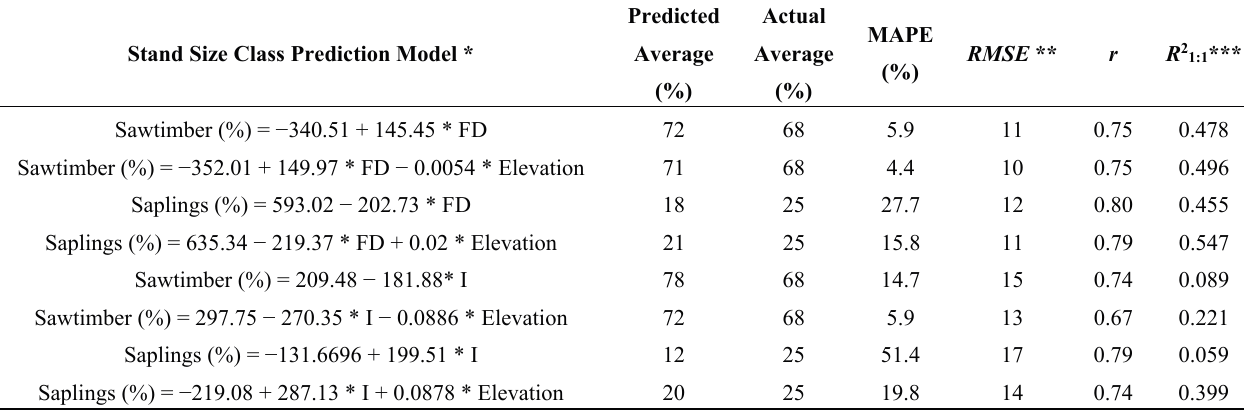
Table 8. Stand Size Classes Prediction Models’ Performance Evaluation Measures (Using the Predicted and Actual Values of All Samples).